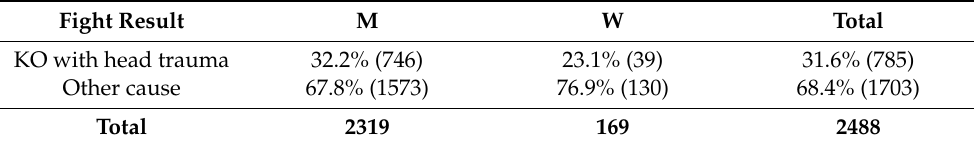
Table 1. Fights ended due to knockout (KO) with head injury by fighter gender.